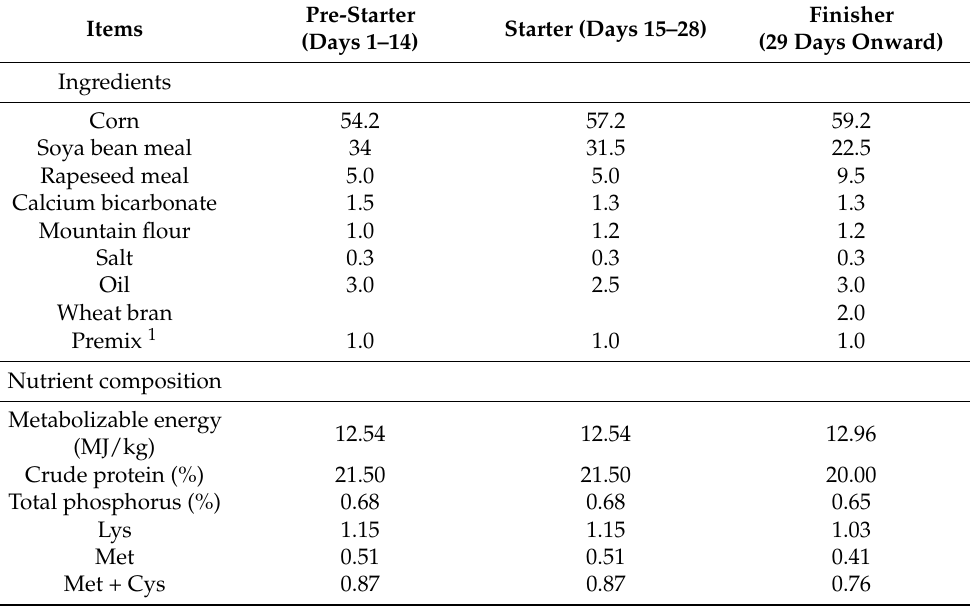
Table 1. Nutrient composition of the basal diet